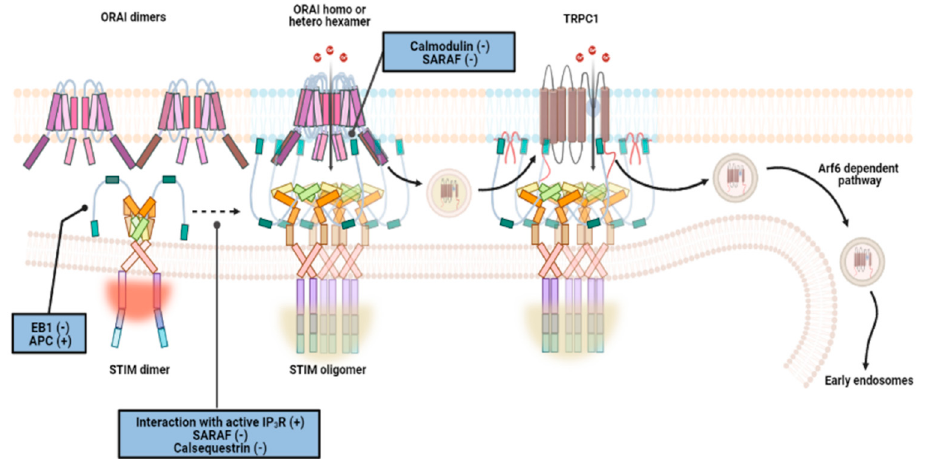
Figure 8. Store-operated Ca 2+ entry with TRPC1. Per the store-operated Ca 2+ influx complex (SOCIC) model, Ca 2+ influx mediated via STIM-ORAI complex has oscillatory patterns whereas bulk cellular entry of Ca 2+ ions is mediated via TRPC1-STIM1 complex [122,124,146]. As described in the model, depletion of Ca 2+ ions from the luminal space of the endoplasmic reticulum promotes oligomerization of STIM dimers on ER membrane [105,142,147,148]. Various STIM interacting proteins regulate this process including SARAF, calsequestrin, and activated IP3R. The symbol opposite each of these proteins in the figure depicts the outcome of their interaction with STIM on its oligomerization. As regulators of STIM insertion in the ER membrane, EB1 and APC indirectly influence STIM-ORAI puncta formation as well [136]. ORAI subunits also translocate from low lipid regions (yellow) on the plasma membrane to cluster into hexamers within cholesterol-rich lipid rafts (green). The ORAI-STIM puncta formation allows Ca 2+ entry while simultaneously triggering detachment of TRPC1 from caveolae in vesicles and insertion into lipid-rich rafts on the plasma membrane [139,141]. From thereon, functional coupling between TRPC1 and STIM brings a large intracellular flow of Ca 2+ ions. Activated ORAI hexamer also is purported to promote TRPC1 insertion into lipid rafts. After SOCIC-mediated Ca 2+ ion influx, Rab4 coated vesicles transport TRPC1 via the Arf6 pathway to early endosomes for recycling [140,141]. APC, adenomatous polyposis coli; Arf6, ADP ribosylation factor 6; EB1, microtubule plus end-binding protein; SARAF, SOCE-associated regulatory factor. Transfer of Ca 2+ ions from ER to mitochondria occurs at specialized microdomains or contact sites known as Mitochondrial Associated Membranes (MAMs). These are characterized by the ER and OMM apposed at 10–25 nM from each other and are strewn with a cluster of channels, transporters, exchangers, and tethering proteins for facilitating Ca 2+ ion transfer [151–154]. IP3Rs localized at the ER side of the MAMs release Ca 2+ ions that gate voltage-dependent anion channels (VDACs) located on the OMM [149,153]; Figure 9A. VDACs (1, 2, and 3) are 30 kDa polypeptides having a 19-strand beta-barrel structure that regulates the flux of metabolites (polyvalent anions like ADP and ATP) across the outer mitochondria membranes [155]. These channels transport cations including Ca 2+ more readily than anions like chloride. Due to voltage-dependent electrostatic gating, the ion selectivity and flux across VDACs change between open and closed states. For instance, the movement of alpha-helix positive charge to the channel outer walls in the closed state increases Ca 2+ ion flux by 10 times relative to the open state. The importance of proximity between IP3Rs and VDACs in MAMs became clearer when it was realized that the channels on the inner mitochondrial membrane (IMM) transporting Ca 2+ ions into the matrix have a low affinity (Km ~5–10 mM, KD ~10–50 mM) to these cations [151,156]. These channels, known as Mitochondrial Ca 2+ Uniporters (MCUs), are highly selective for Ca 2+ ions, and their opening demonstrates sigmoidal dependence on the cation concentration partly due to lowering of Ψ mt that subsequently diminishes drive for cation flux. MCU (40 kDa protein) oligomers form a functional multi-protein complex with their